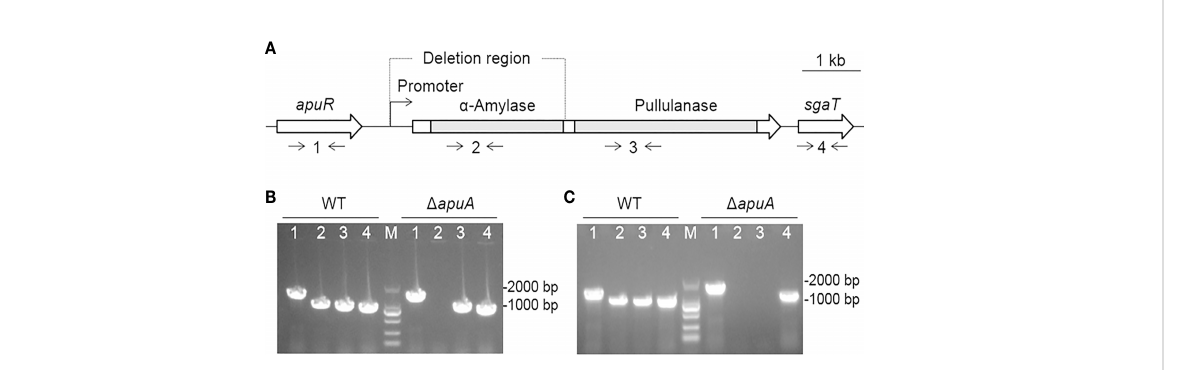
FIGURE 4 Construction and con fi rmation of the deletion mutant strain D apuA . (A) Genetic map of the loci encoding ApuA in the S. suis genome. Two gray bars represent the coding regions of a -amylase and pullulanase of apuA , respectively. Numbers 1 – 4 represent the detection primer pairs apuR-F/apuR-R, amy-F/amy-R, pul-F/pul-R, and sgaT-F/sgaT-R, respectively. (B) Combined PCR analyses of D apuA . Numbers 1 – 4 represent the speci fi c DNA fragments ampli fi ed with corresponding primers in Figure 2A. M represents the DNA marker (100 – 2000 bp). (C) Con fi rmation of the transcriptional inactivation of apuA by real-time PCR. Numbers 1-4 represent the speci fi c DNA fragments ampli fi ed with corresponding primers in Figure 2A. M represents the DNA